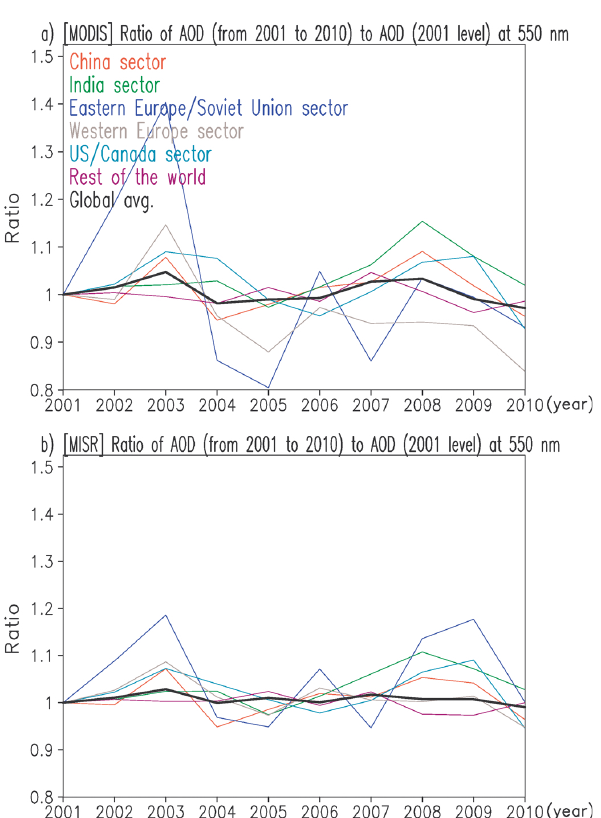
Fig. 10. Ratio of regionally averaged annual-mean AOD to its 2001 level. Here, we use MODIS and MISR data on the T42